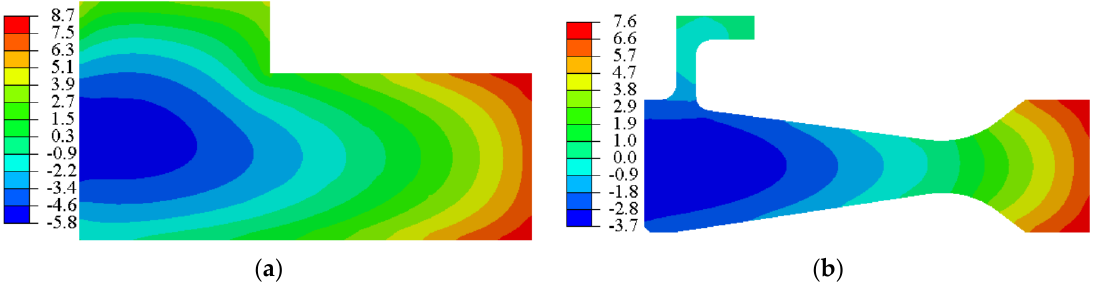
Figure 7. Residual hoop stress after AC. ( a ) Rough machined workpiece ( b ) Finishing disc.